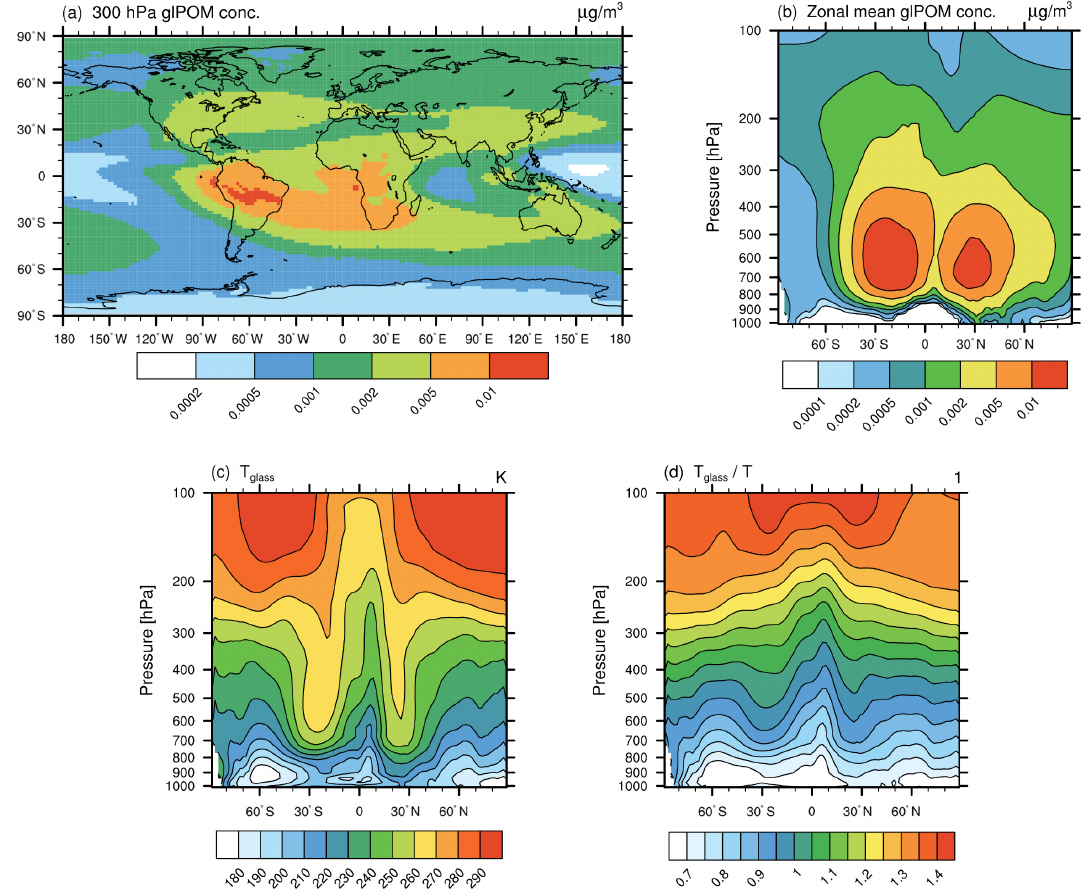
Figure 2. Global distribution of glassy organics (glPOM) at the 300hPa pressure level (a) and as a zonal mean (b) in micrograms per cubic metre (µgm − 3 ), as simulated with EMAC-MADE3. Panels (c) and (d) show the zonally averaged glass transition temperature ( T g ) in kelvin (K) and the T g /T ratio respectively. All panels consider the multi-year average over the simulation period (2010–2019). Note the different scales in each